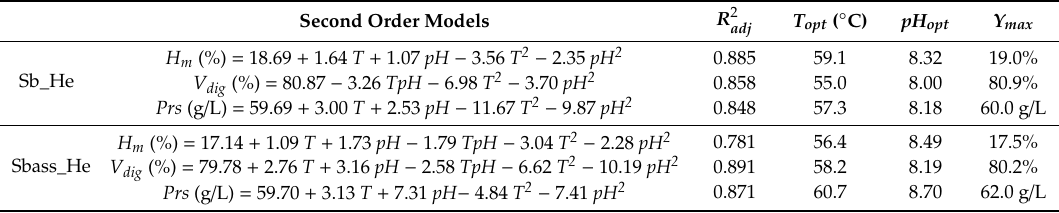
Table 2. Polynomial equations describing the joint e ff ect of pH and temperature ( T ) on Alcalase proteolysis of Sb_He and Sbass_He. Optima values of both independent variables ( T opt , pH opt ) to reach the predicted maximum responses ( Y max ) were also calculated.